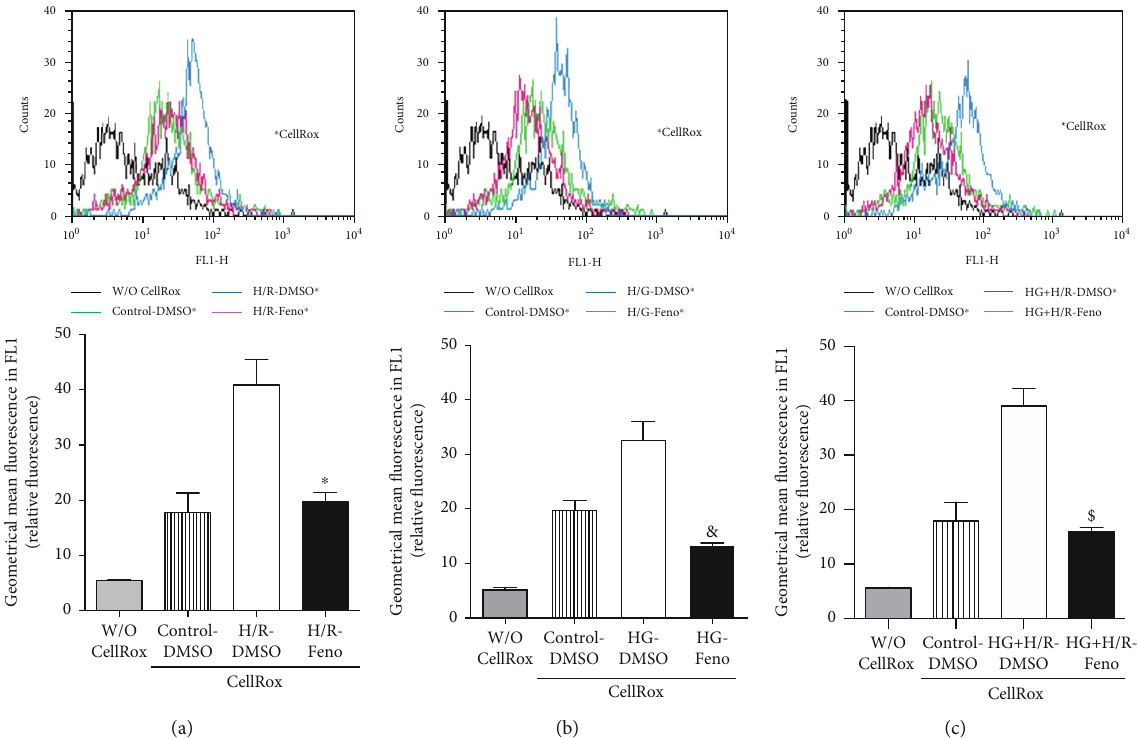
Figure 4: Electropherograms and quanti fi cation of ROS production by fl ow cytometry in primary cultures of cardiomyocytes under (a) hypoxia/reperfusion (H/R), (b) high glucose (HG), or (c) HG+H/R. ∗ p < 0 : 05 vs. H/R-DMSO; & p < 0 : 05 vs. HG-DMSO; $ p < 0 : 05 vs. HG+H/R-DMSO. W/O CellRox = blank; CellRox = vehicle; DMSO = dimethylsulfoxide (0.1%); Feno = feno fi brate (10 μ M). Values represent the mean ± SEM of 6 di ff erent experiments. Two-way analysis of variance (ANOVA) followed by Tukey ’ s post hoc